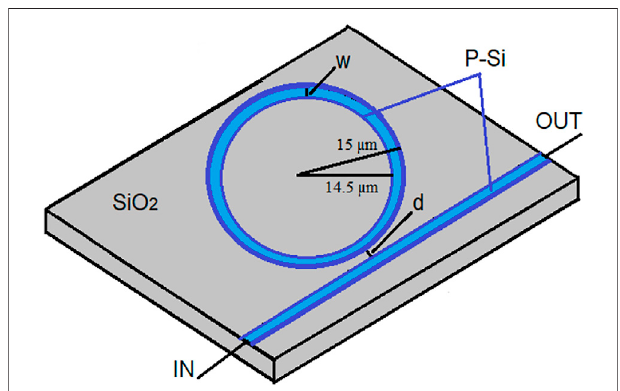
FIGURE 1 | Cross-section of the proposed microring resonator – based temperature sensor.